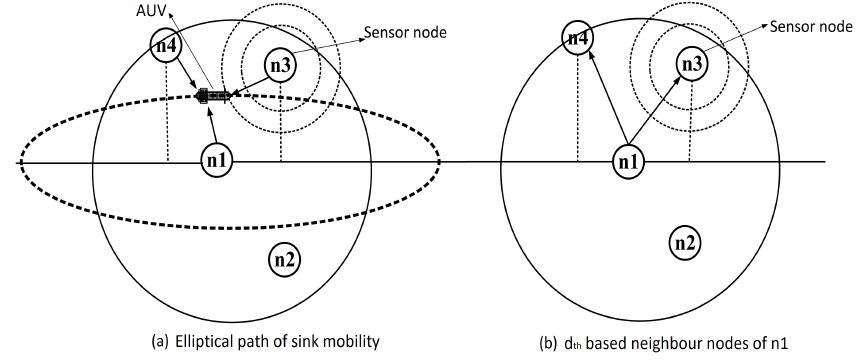
Figure 5. ADTM with sink